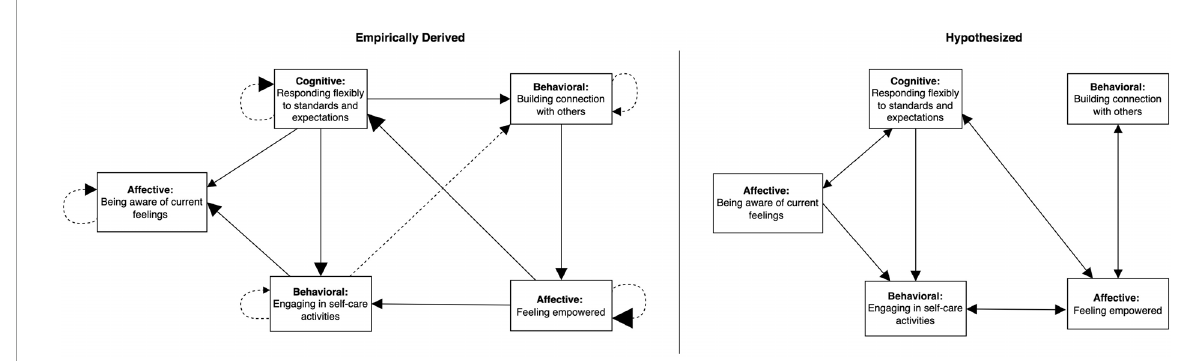
FIGURE9 Group Iterative Multiple Model Estimation-derived network showing contemporaneous and lagged relationships among EMA items completed by Amy in the final few weeks of treatment on the left, compared to our hypothesized network on the right. Solid lines, contemporaneous; dashed lines, lagged; solid arrowhead, excitatory or positive relationship. Size of arrowheads corresponds to strength of relationship estimated by GIMME analyses. Beta estimates are presented in Supplementary Table S2 in Supplementary material